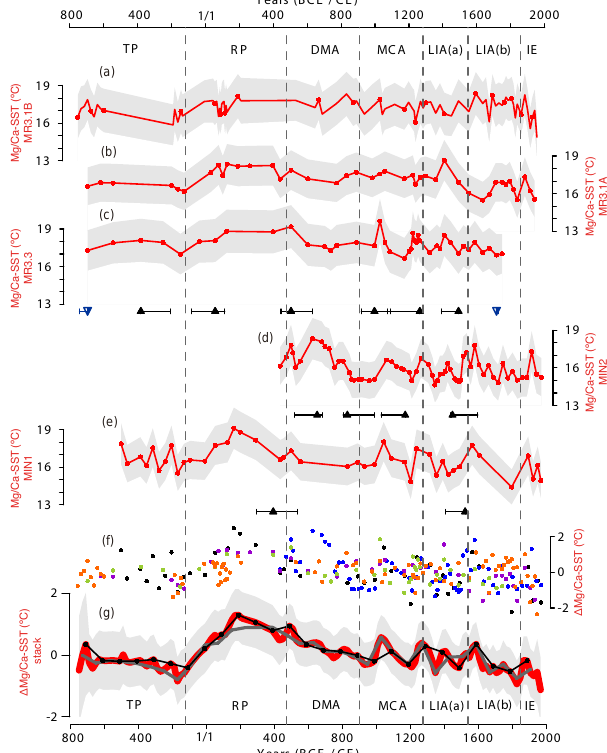
Figure 3. SST obtained from Mg / Ca for cores: (a) MR3.1B, (b) MR3.1A, (c) MR3.3, (d) MIN2, and (e) MIN1. The grey shaded areas integrate uncertainties of average values and rep- resent 1 σ of the absolute values. This uncertainty includes an- alytical precision and reproducibility and the uncertainties de- rived from the G. bulloides core-top calibrations for the central- western Mediterranean Sea developed in this paper. (f) All indi- vidual SST anomalies on their respective time step (MR3.1B: or- ange; MR3.1A: purple; MR3.3: green; MIN2: blue; MIN1: black dots). (g) 20yrcm − 1 stacked temperature anomaly (red plot) with its 2 σ uncertainty (grey band). The 80yrcm − 1 (grey plot) and the 100yrcm − 1 (black plot) stacks are also shown. The triangles repre- sent 14 C dates (black) and biostratigraphical dates based on plank- tonic foraminifera (blue) and are shown below the corresponding core, including their associated 2 σ